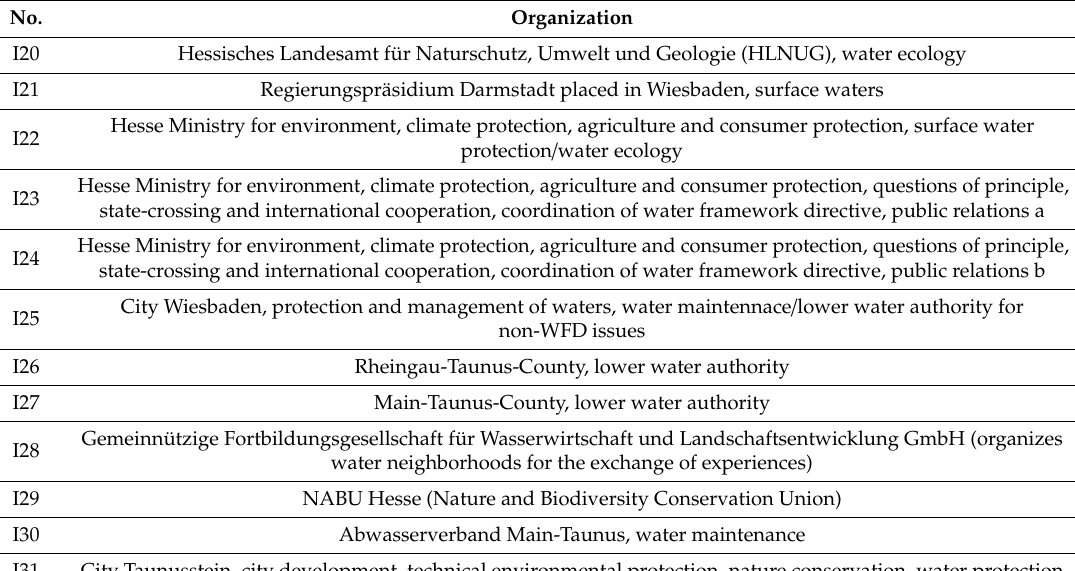
Table A3. Hesse: September, November